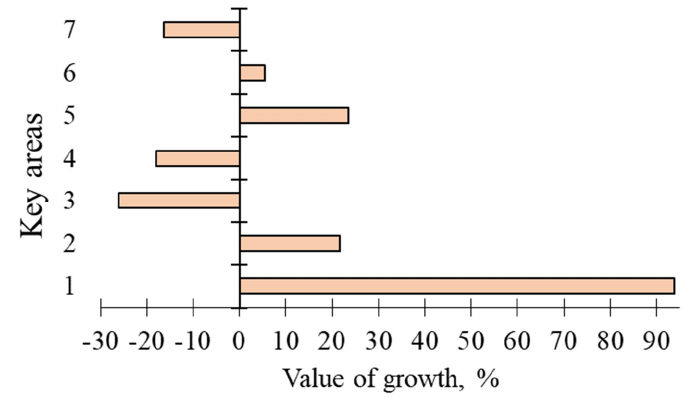
Figure 12. The density dynamics of the ephemeral gully network (Mesha river basin) for the period 1988 to 2015.